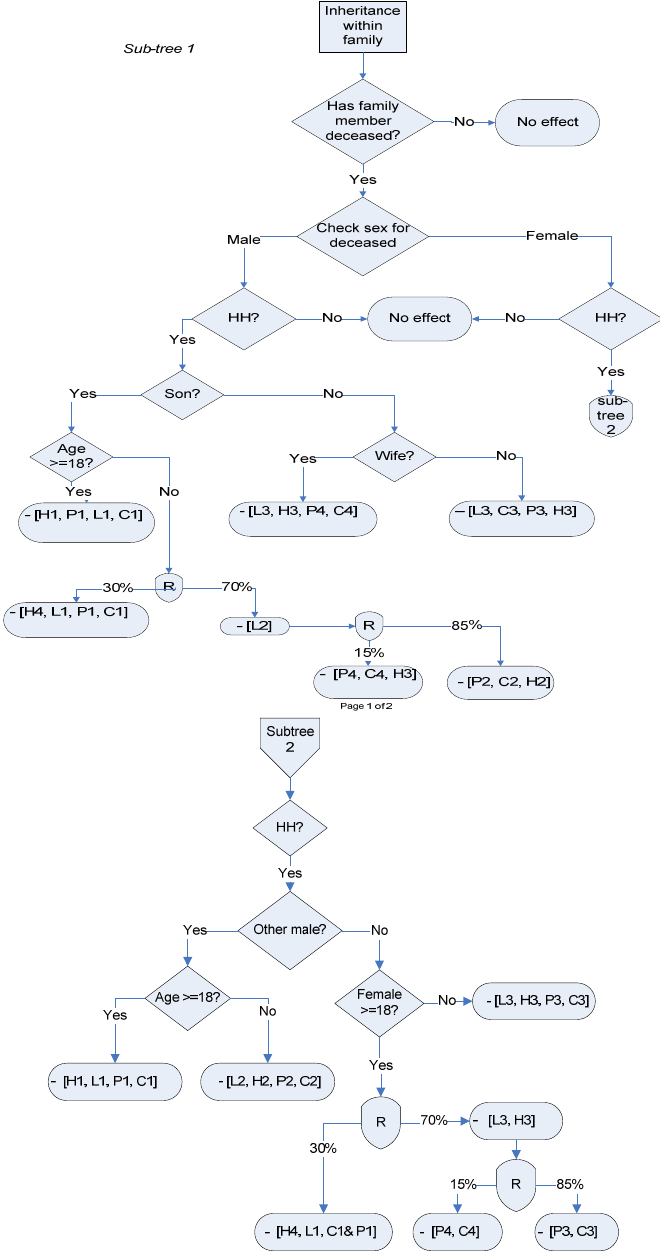
Figure 3. Model of the interrelationships between HIV/AIDS, labor, agriculture, food security, and